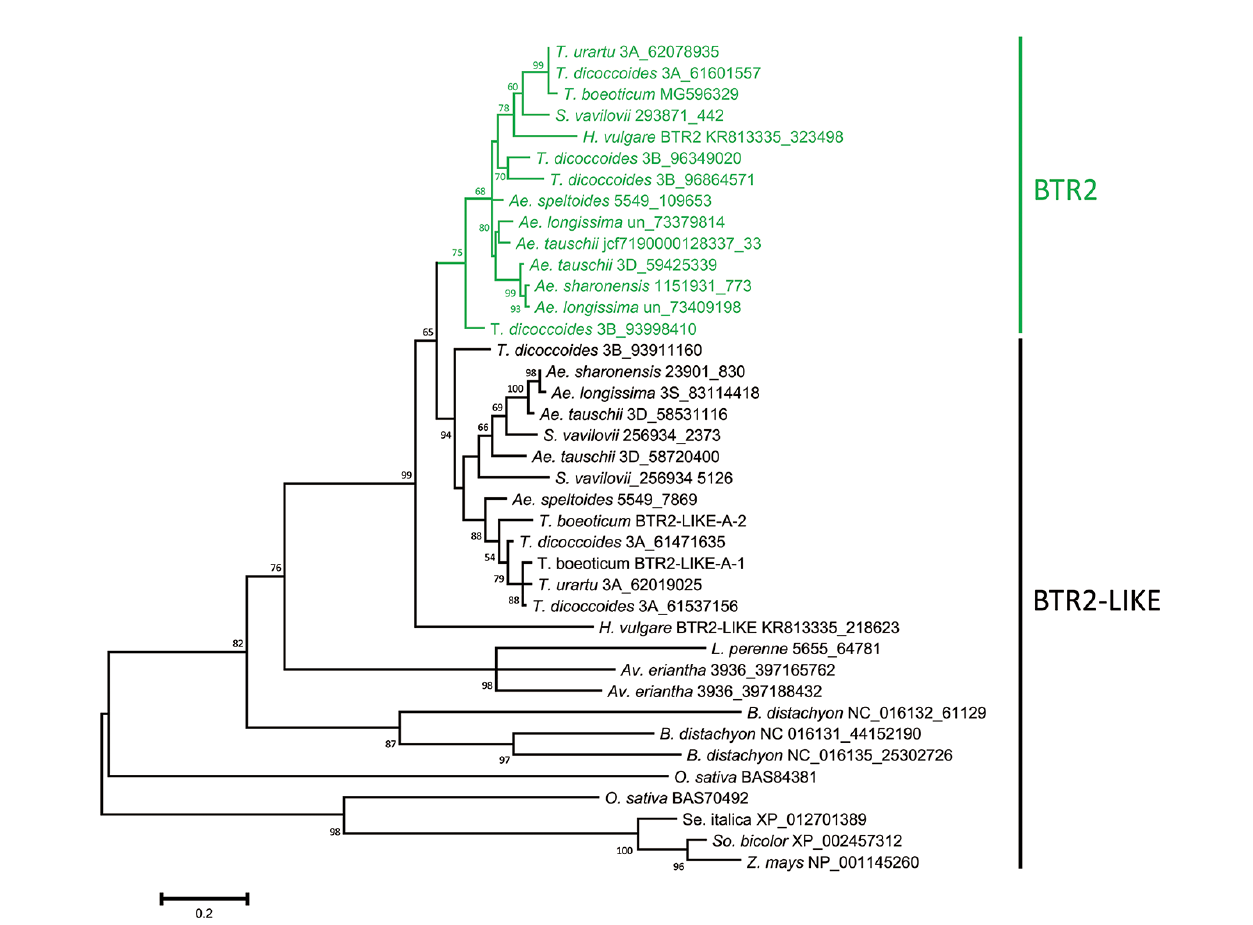
FIGURE 3 | Phylogeny of the Poaceae BTR2 and BTR2-like proteins. The tree was constructed using the maximum likelihood method based on an alignment of deduced polypeptide sequences. The products of the Btr2 genes are shown in green. Numbers given at a branch node indicate bootstrap probabilities (only those > 50% are shown). Accession/scaffold/contig numbers and the start location of each gene is given in Table S6